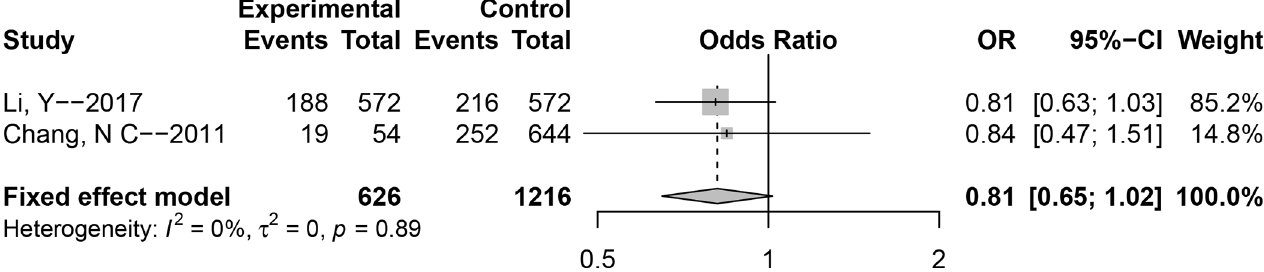
PLOS ONE | https://doi.org/10.1371/journal.pone.0188539 November27,